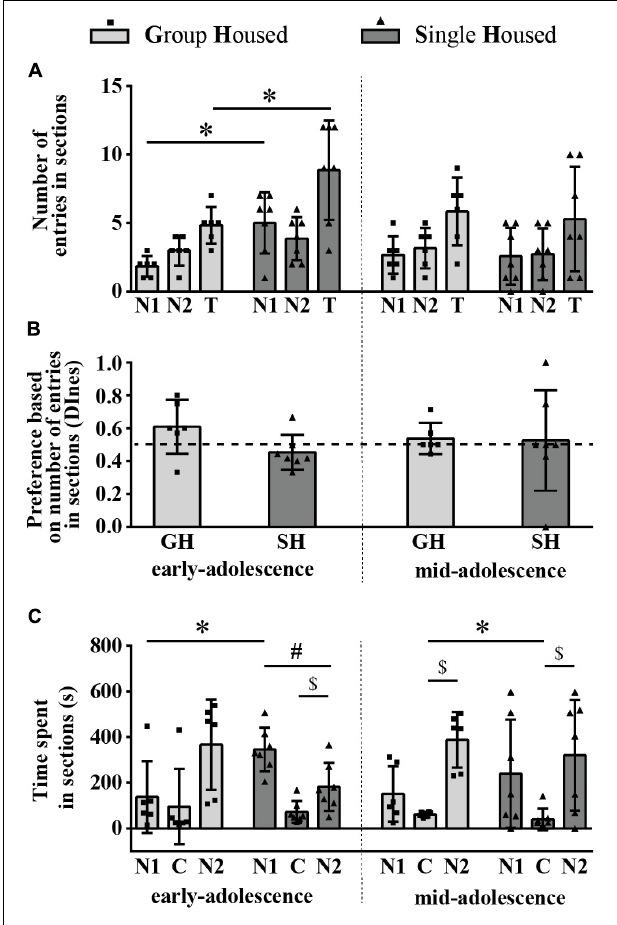
FIGURE 5 | The preference for novel social space in peripubertal male rats at the end of the first week (early-adolescence) and the second week (mid-adolescence) of defined housing, which began on the 29th postnatal day. The parameters were obtained in the 3-chamber test. The data are represented as mean ± SD , with individual data plots along the column bars. (A) The number of entries into compartments/sections with the familiar conspecific (N1), the novel conspecific (N2), and the total number of entries (T). (B) Discrimination index based on the number of entries into sections (DInes), addressing “wanting” aspect of the preference for the section with social novelty (N2 section). (C) Time spent in the N1 section, N2 section and central (C) section, reflecting “liking” aspect of the preference for the section with social novelty (N2 section) over other two sections; $ p ≤ 0.05 (time spent in the N2 section vs. time spent in the C section); # p ≤ 0.05 (time spent in the N2 section vs. time spent in the N1 section); ∗ p ≤ 0.05 (single housed vs. group housed within the same maturational period). Statistical comparisons and exact p -values are given as Supplementary Table S1